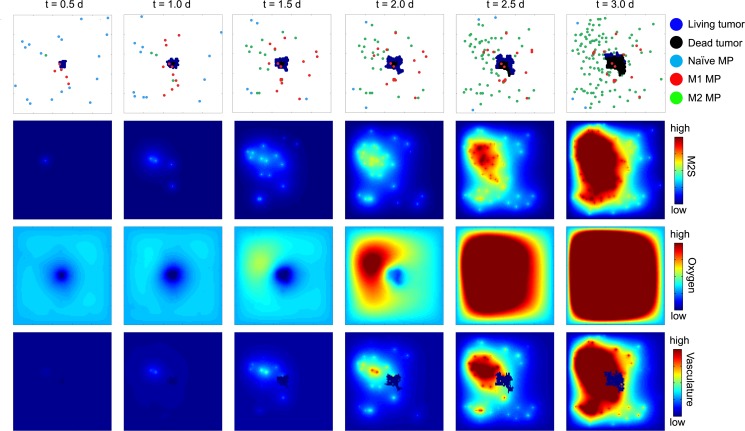
Qualitative recapitulation of tumor physiology.Qualitative behavior of the model is illustrated through snapshots in time from a single run of the HDC model using base parameter values. At each time point post-tumor initiation (in days), spatial distributions of cells (by type), M2S, oxygen, and vasculature are depicted. In this particular run, shortly after the final time point shown, all tumor cells were dead. Numerical ranges spanned by colored scale bars are: M2S (0–4 [pg/LS] x 10–6), oxygen (0–1 [pg/LS]), vasculature (0–40 au).